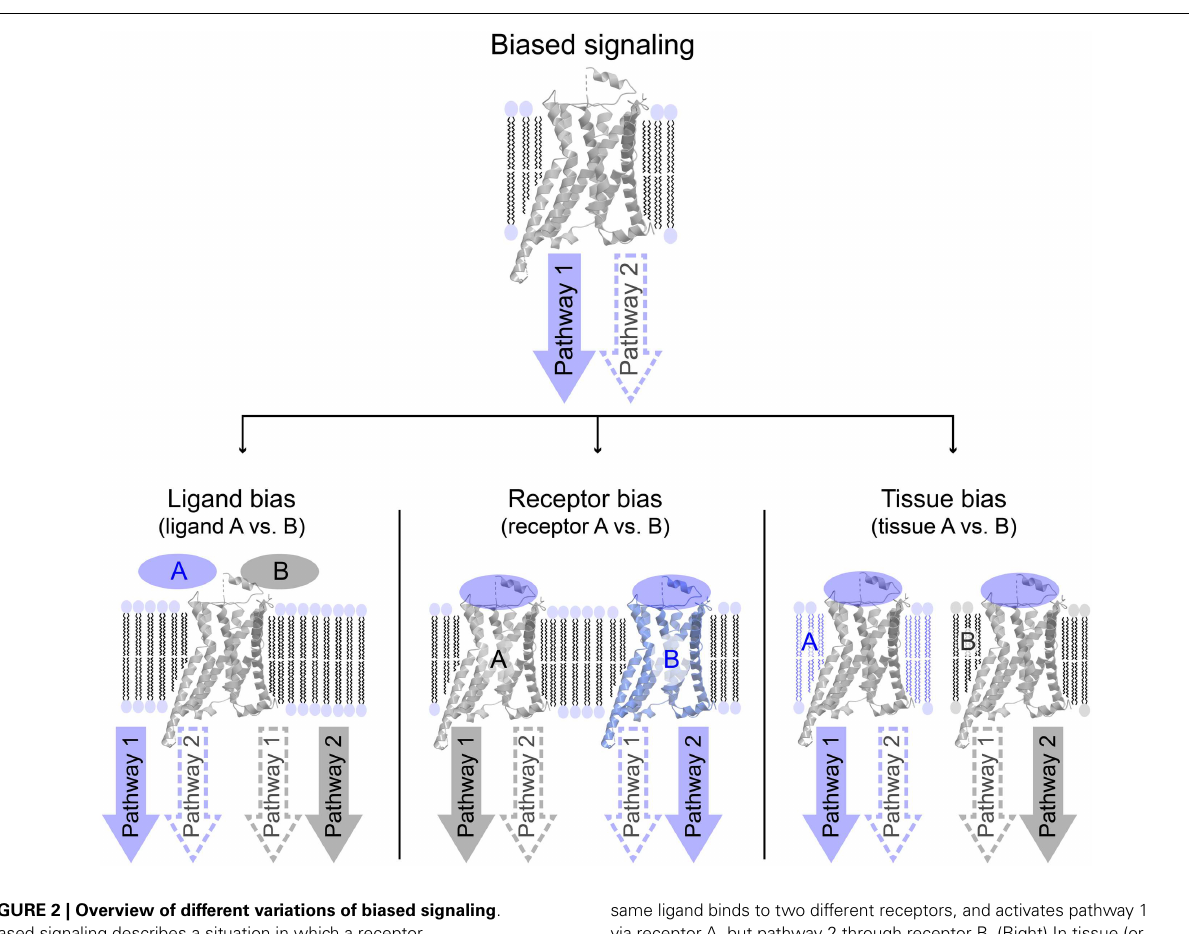
same ligand binds to two different receptors, and activates pathway 1 via receptor A, but pathway 2 through receptor B. (Right) In tissue (or cell) bias, the same ligand: receptor-complex is activated in two different tissues or cell types (or different species), and in tissue A pathway 1 is preferentially activated, whereas pathway 2 is more likely to be activated in tissue